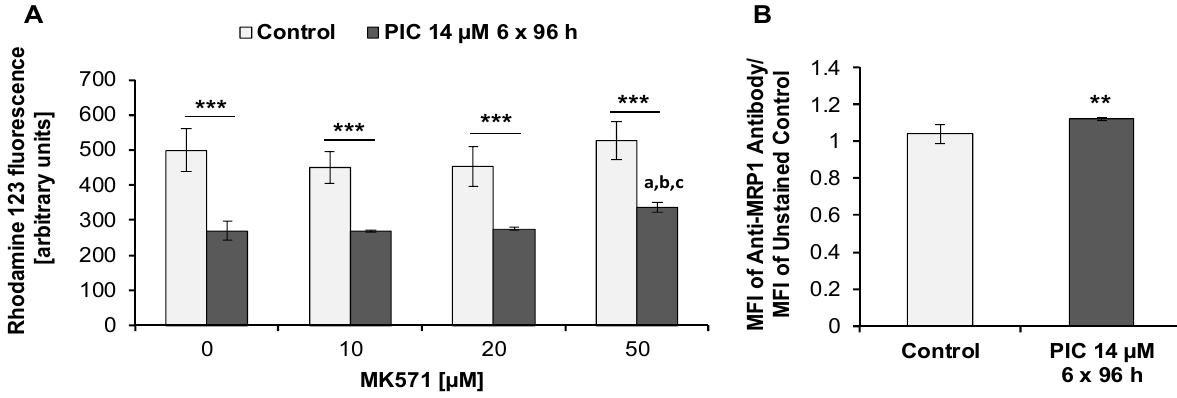
Figure 9. Detection of MRP1 in HL-60 cells. Cells were exposed to piceatannol (PIC, IC 90 = 14 µ M) for six repeated treatment cycles (6 x 96 h). ( A ) MRP1 activity analysis (flow cytometry analysis). Rhodamine 123 uptake/retention assay was performed in the presence and absence of MK571. Data are presented as means ± SD of three independent experiments in duplicates. *** p < 0.001, statistically significant differences between piceatannol-treated cells and untreated cells incubated in the absence or presence of MK571. a p < 0.001, statistically significant differences compared to piceatannol-treated cells incubated without MK571; b p < 0.001, statistically significant differences compared to piceatannol-treated cells incubated with 10 µM MK571; c p < 0.001, statistically significant differences compared to piceatannol-treated cells incubated with 20 µM MK571 (One-way ANOVA, Tukey’s post hoc analysis). ( B ) Expression of MRP1 in HL-60 cells. Control (untreated cells) and piceatannol-treated cells were stained with anti-MRP1 (QCRL-3) antibody (flow cytometry analysis). Data are presented as means ± SD of three independent experiments in duplicates. ** p < 0.01, statistically significant differences between piceatannol-treated cells and untreated cells (Mann–Whitney U-test).